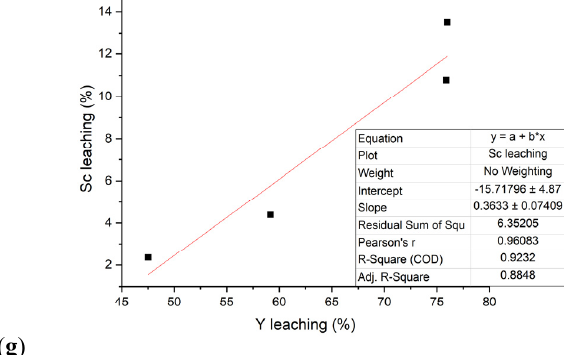
Figure 9. Correlation between the leaching rates of scandium and ( a ) iron, ( b ) titanium ( c ) zirconium, ( d ) lanthanum, ( e ) cerium, ( f ) neodymium, and ( g ) yttrium rates in different temperatures. Experi- mental conditions: 100 mL of H 2 SO 4 4.0 mol/L; 1 v / v % H 2 O 2 ; solid-liquid ratio = 1/10; t = 8 h; stirring speed = 200 rpm. Table 6. Arrhenius data for the leaching of iron, zirconium, lanthanum, cerium, neodymium, yt- trium, and scandium, varying the temperature. Experimental conditions: 100 mL of H 2 SO 4 4.0 mol/L;